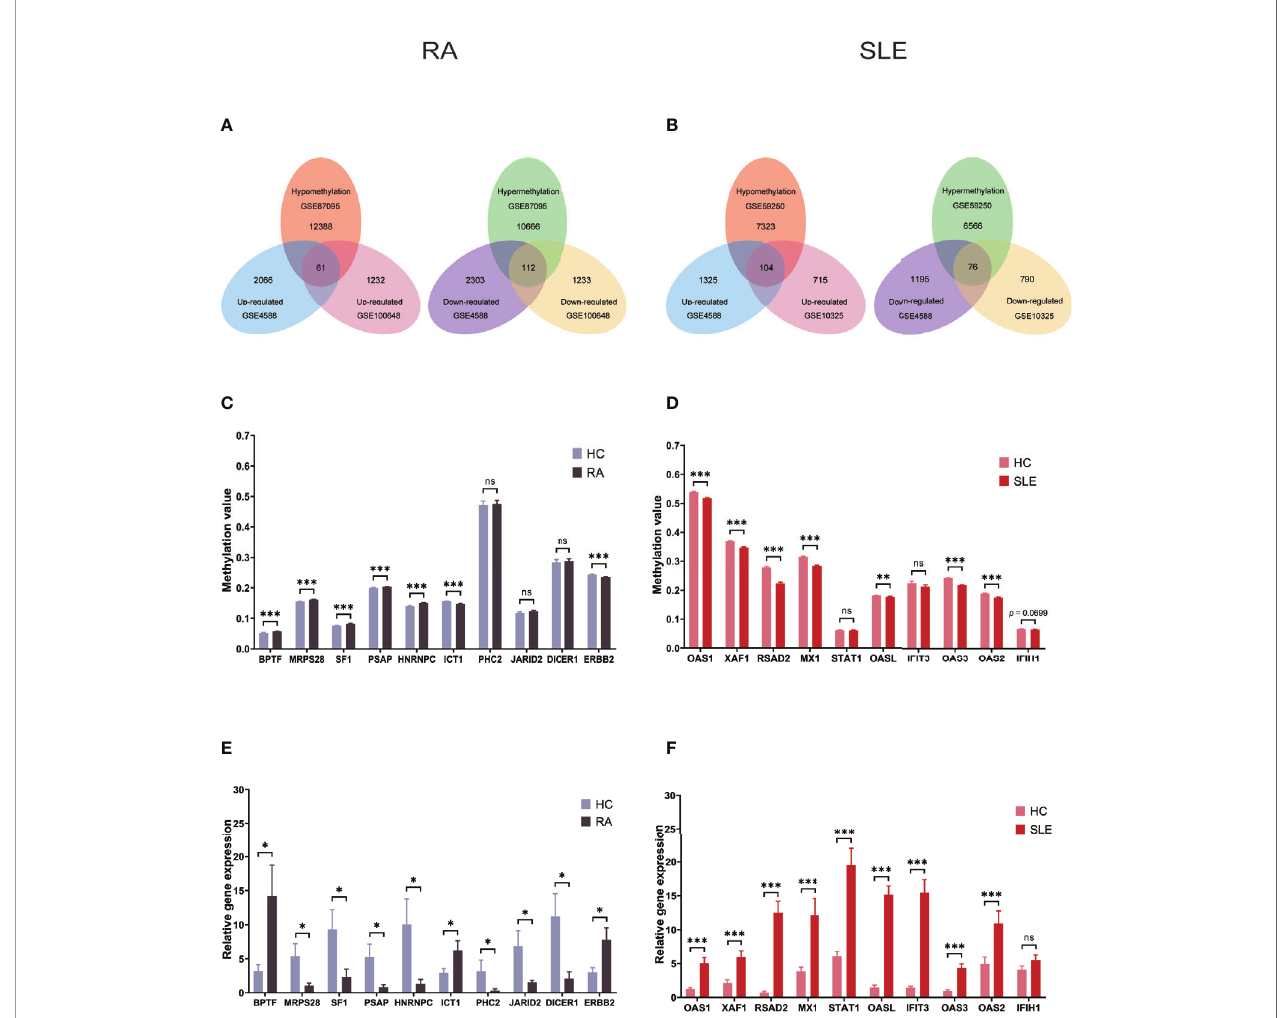
FIGURE 2 | Identi fi cation of abnormally methylated DEGs of CD19 + B cells in RA and SLE. (A) Unusually methylated DEGs of CD19 + B cells in RA and (B) SLE; (C) Methylation level of top 10 hub genes in CD19 + B cells from RA and (D) SLE; (E) Expression levels of top 10 hub genes in CD19 + B cells from RA and (F) SLE. ns, not signi fi cant. *p < 0.05; **p < 0.01; ***p <